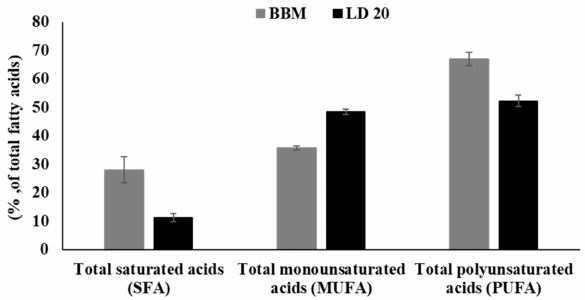
Figure 4. Comparison of the composition of fatty acids (C16–C18) grouped as total saturated acids, total monounsaturated acids, and total polyunsaturated acids. The grey columns represent the control BBM medium and the black columns represent 1:20 liquid digestate (LD